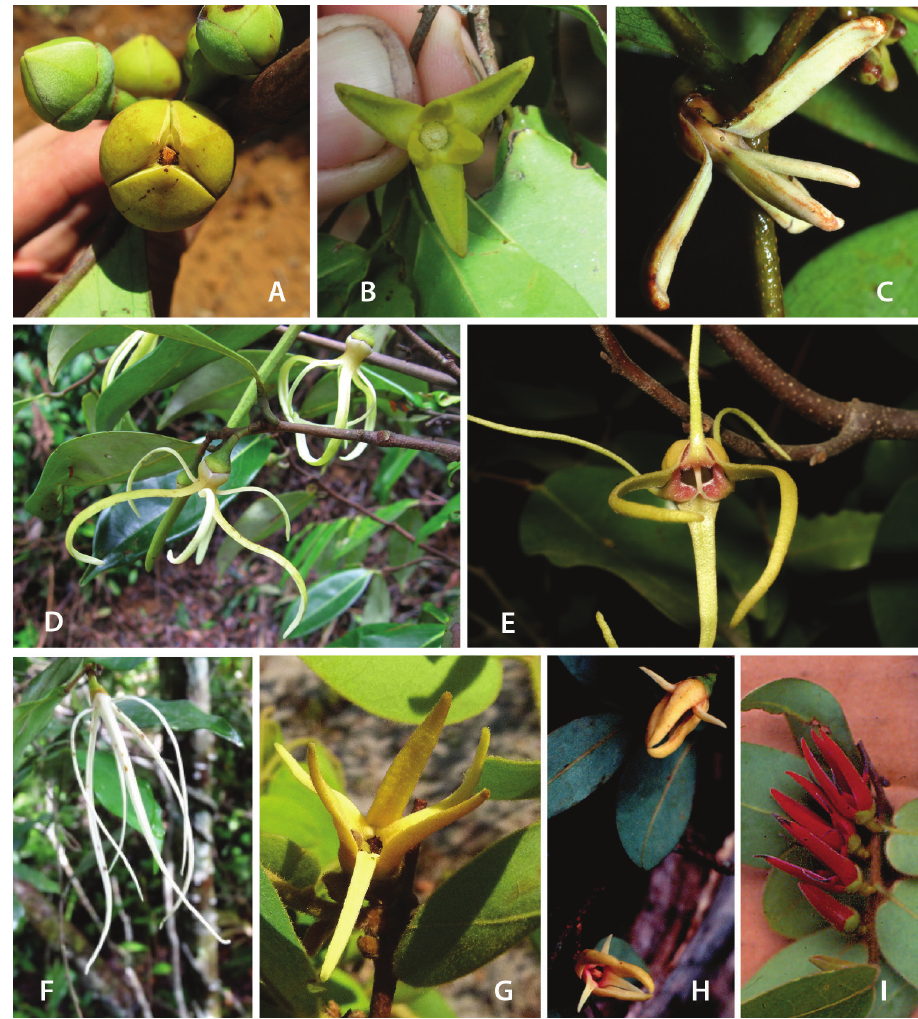
Figure 3. Flowers of representative Xylopia species. A Flower from type collection of Xylopia globosa from Gabon B Xylopia tenuipetala from Mozambique C Xylopia quintasii from Gabon D Xylopia aethiopica from Gabon E Xylopia longipetala from Mali, representing a record for the country not otherwise documented F Xylopia piratae from Ivory Coast G Xylopia odoratissima from Zambia H Xylopia arenaria from Tanzania I Xylopia collina from Tanzania. A, D by Thomas L. P. Couvreur B by Frances Chase C by Ehoarn Bidault E by Philip Birnbaum F by Céline Pirat G by Warren McClelland H and I by D. M. Johnson. from ca. 65 in X. lukei D. M. Johnson & Goyder to as few as 40 in X. aurantiiodora and X. mwasumbii . The apex of the anther connective in species of sect. Ancistropetala is globose or conical and does not overhang the thecae, lending a pebbly appearance to the surface of the androecium, in contrast to the typical flat surface; in species of sect. Verdcourtia , the apices are rudimentary (≤0.1 mm long). Filaments exceeding 0.6